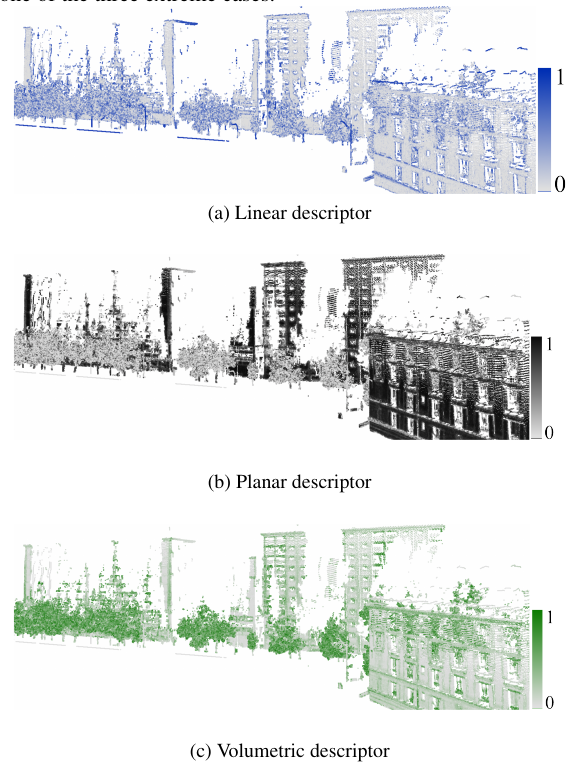
Figure 3: Response of the different geometrical